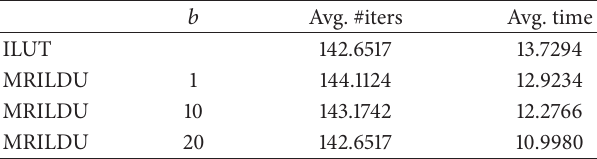
Table 15: Iteration results for linear systems from GRAPES. Table 16: Iteration results for static loading of concrete